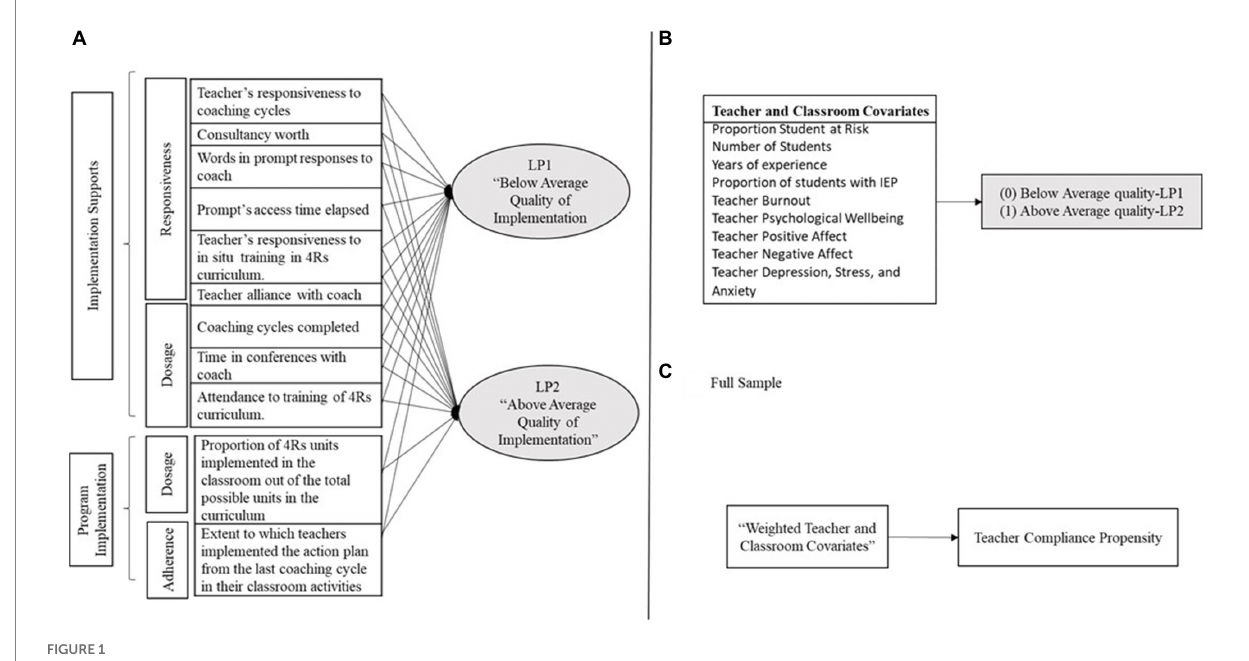
FIGURE 1 (A–C) Models guiding the estimation of teacher compliance